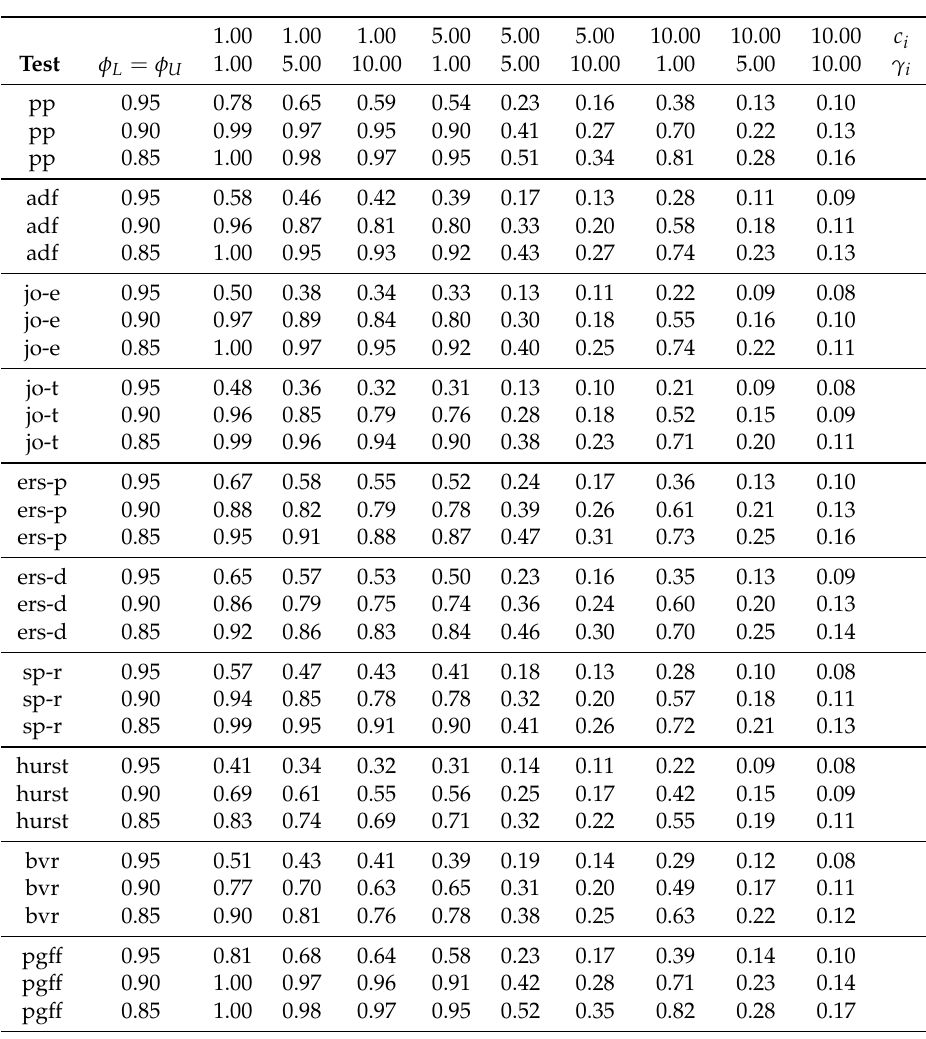
Table 11. Power of cointegration tests for Monte Carlo settings of Type IV, as described in Subsection